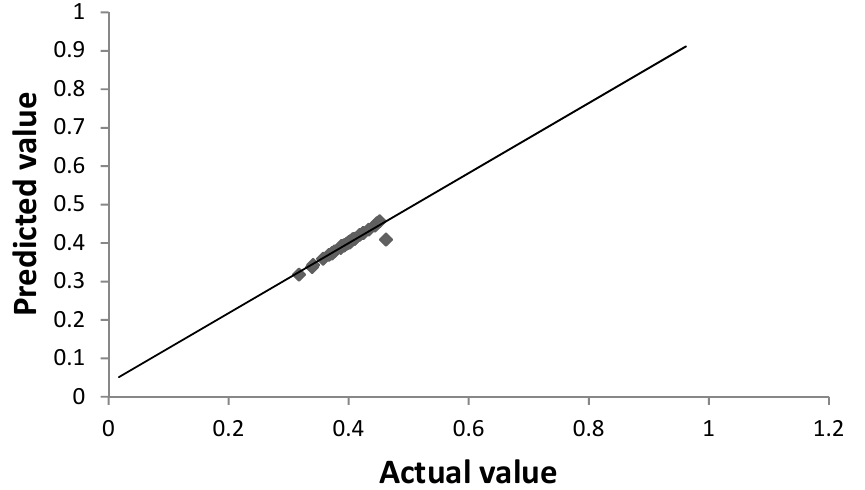
Figure 2. Observed and predicted values of biovanillin production.